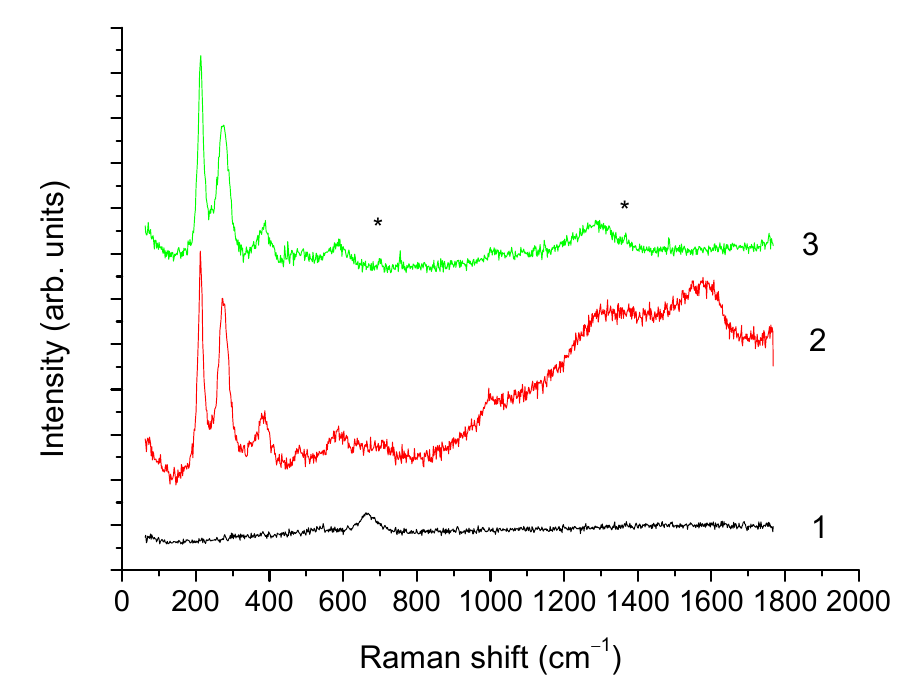
Figure 5. X-ray diffraction pattern of the isolated magnetosomes.